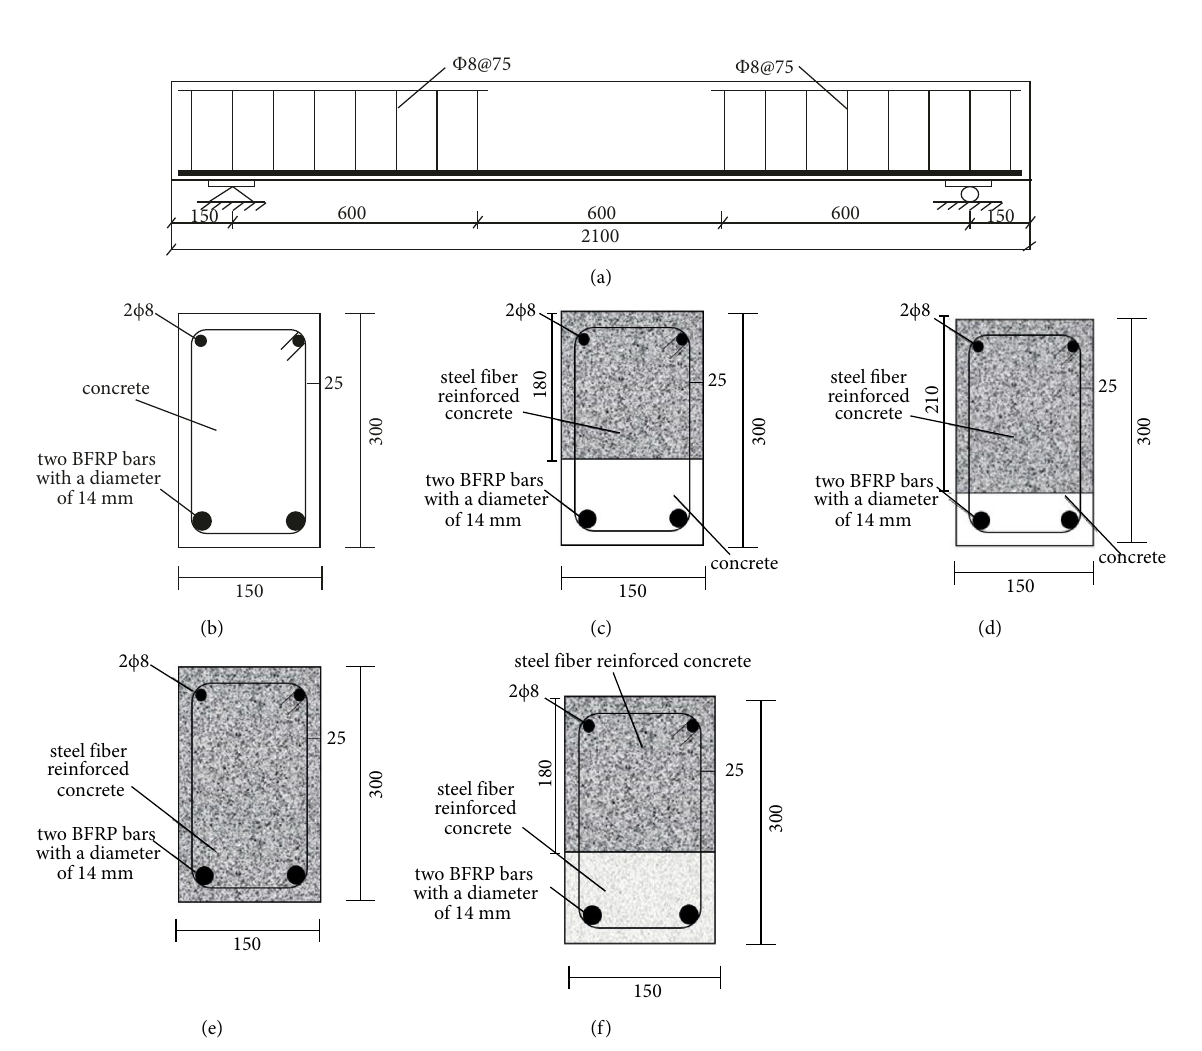
Figure 2: Specimen size. (a) Side view of test beam. (b) B1 section. (c) B2/3/4 section. (d) B5 section. (e) B6 section. (f) B7